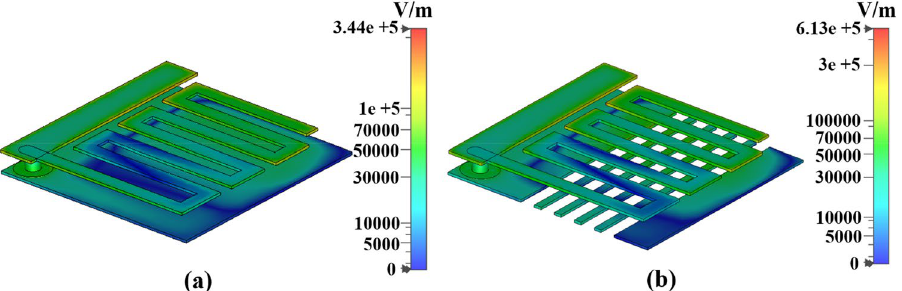
Figure 7. The influence of floor slotting on antenna electric field distribution ( a ) intact ground ( b ) slotted